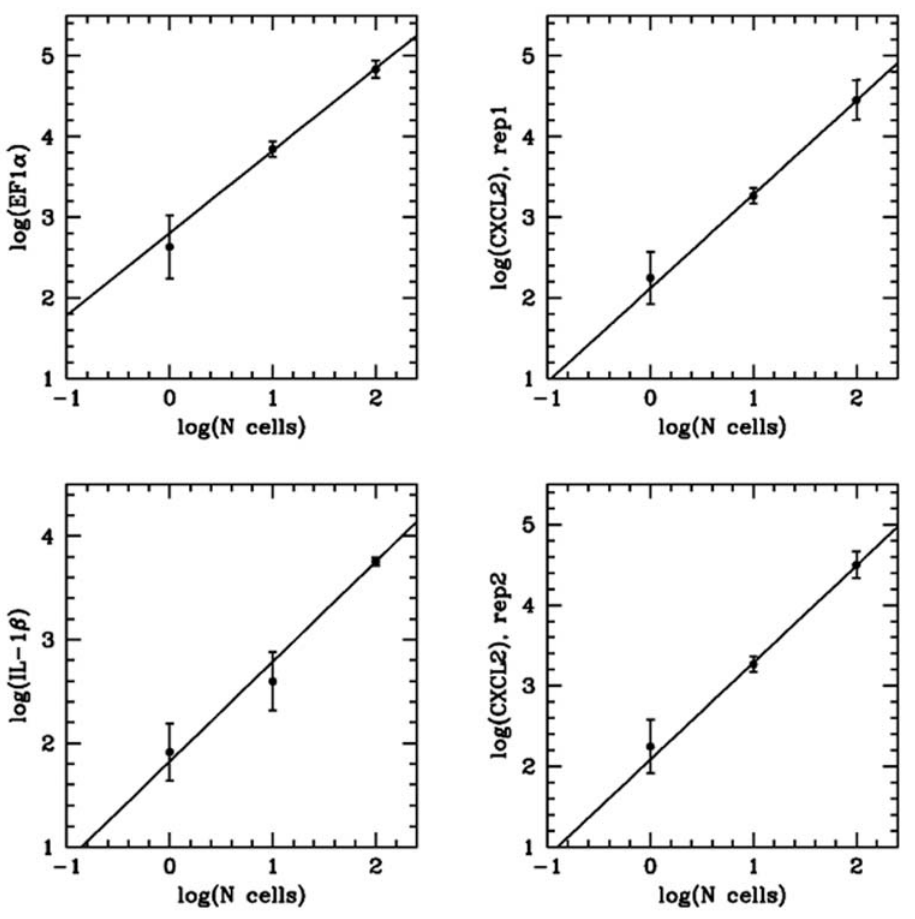
Figure 1. Sensitivity for single-cell mRNA measurements. Macrophages were activated with the bacterial stimulus, lipopolysaccharide (30 ng/ ml for 2 hours), and the indicated number of cells (1, 10 or 100 cells) were sorted by flow cytometry. mRNA expression of the indicated genes was measured by real-time PCR using 1/8 th of the sample cDNA lysate per measurement. The mean and standard deviation of 12 samples are presented for each of the indicated number of cells. The C t values were arbitrarily scaled to log 10 values (y-axis).